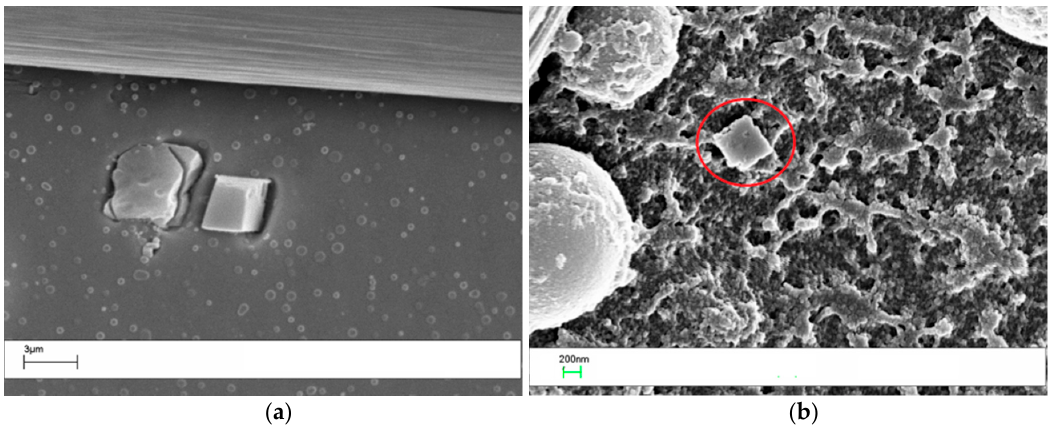
Figure 12. SEM of the laminate with the coPES/5% POSS veil dissolved in it: ( a ) low resolution (4000×, sx) and ( b ) high resolution (60,000×, dx). Polymers 2017 , 9 , 281